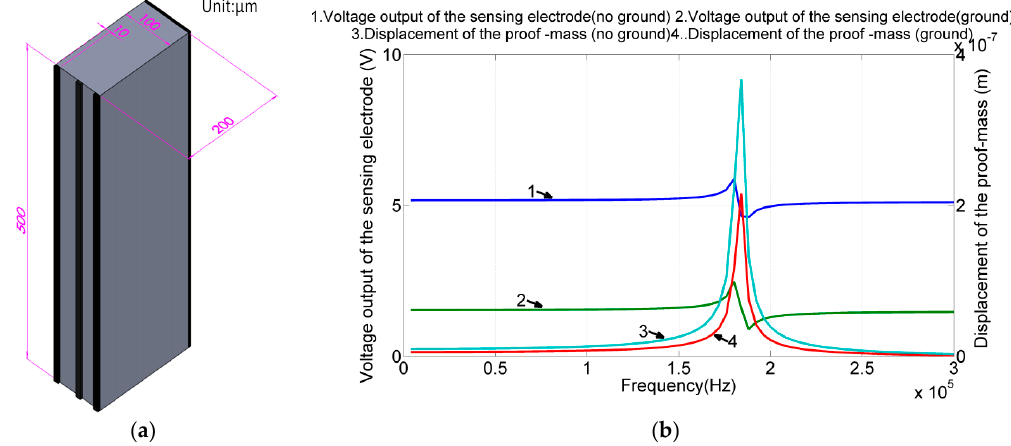
Figure 7. ( a ) Piezoelectric cantilever beam for testing the design of the ground electrode. ( b ) When voltage was applied to the driving electrode, the displacement in the case with the ground electrode was slightly greater than that in the case without the ground electrode. By contrast, the signal at the sense electrode was smaller than that in the case without the ground electrode.